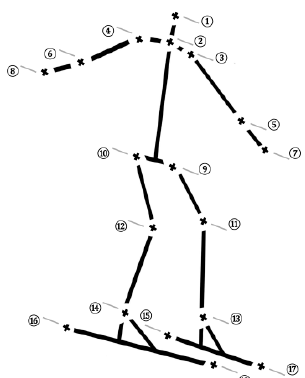
Figure 2. Segment model, including all 18 joint centers and connecting segments considered for analysis. 1: head; 2: neck; 3: left shoulder; 4: right shoulder; 5: left elbow; 6: right elbow; 7: left hand; 8: right hand; 9: left hip; 10: right hip; 11: left knee; 12: right knee; 13: left ankle; 14: right ankle; 15: left ski tail; 16: right ski tail; 17: left ski tip; 18: right ski tip.